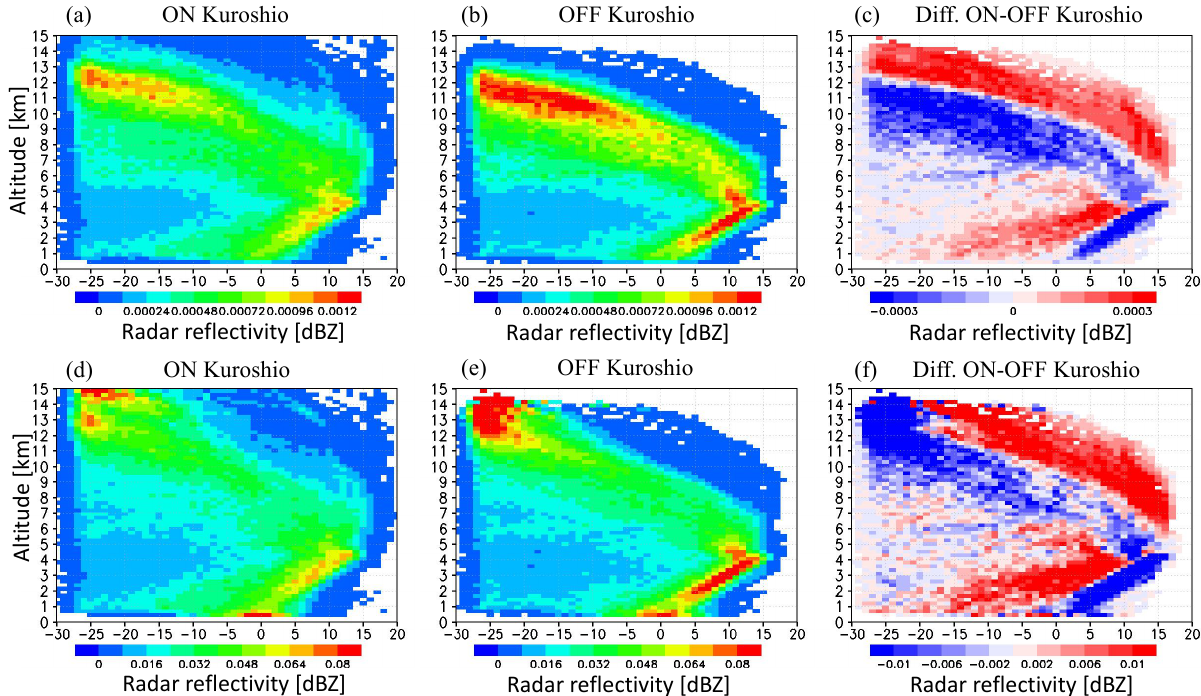
Figure 5. Two-dimensional probability density function for (a) ON Kuroshio, (b) OFF Kuroshio, and (c) ON–OFF Kuroshio, and contoured frequency by altitude diagrams (CFADs) for (d) ON Kuroshio, (e) OFF Kuroshio, and (f) ON Kuroshio–OFF Kuroshio.